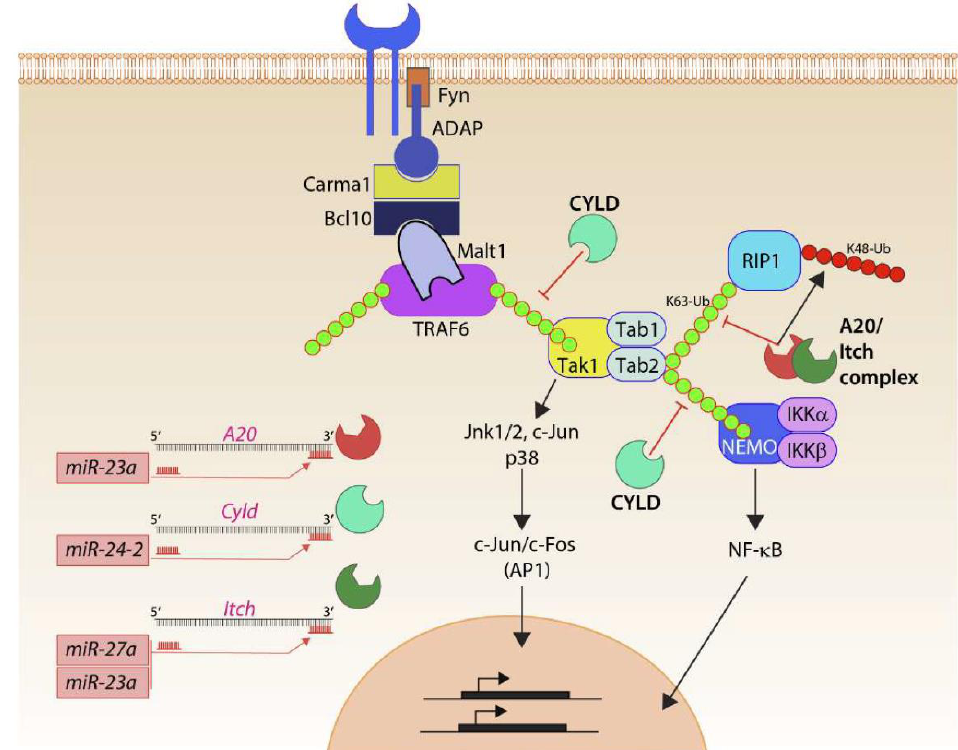
Figure 6. Mirc11 and inflammation. Members of the Mirc11 family function as cytoplasmic check- points to downregulate the functions of ubiquitin modifiers and augment translation of the tran- scripts encoding inflammatory cytokines. Signaling from activation receptors propagate by recruiting membrane-proximal Src kinase Fyn and scaffold protein ADAP. Functions of the ADAP include the assembly of the Carma1-Bcl10-Malt1 (CBM) signalosome. TRAF6 is one of the major ubiquitin E3 ligases in lymphocytes and auto-ubiquitylates K63 moieties of ubiquitin. K63-linked polyubiquitin functions as a scaffold in recruiting downstream effectors, including Tak1 involved in activating AP1 via Jnk1/2, p38, c-Jun. Tak1 also recruits Tab1, Tab2, and Tab3. K63 ubiquitylation of Tab2 allows the recruitment of Rip1 or Nemo and the eventual activation of NF-κB. Ubiquitin modifiers (Itch) and deacetylases (A20, Cyld) are involved in negatively regulating the functions of TRAF6 and Tabs. They achieve this by actively removing the K63 ubiquitin moieties and by adding K48-linked ubiquitin that marks proteins for proteasome-based degradation. Mirc11 family members target Cyld, A20, and Itch. Using ‘seed sequences’, members of the Mirc11 family target sequences in the 3′ end of the transcripts; these microRNAs can function as the positive regulators of NF-κB and AP1 transcription factors.